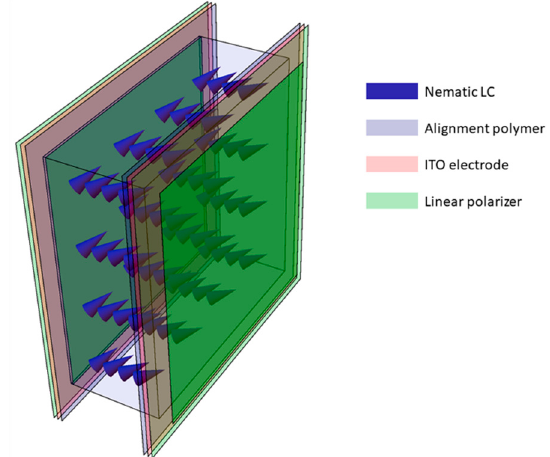
Figure 2. LC cell phase retarder. The LC phase retarder is made of a Nematic LC layer (blue arrow) sandwiched between two glass plates and two linear polarizers (green layers). The glass plates are coated with Indium Tin Oxide (ITO, pink layers) and a polymer alignment layer (purple layers).